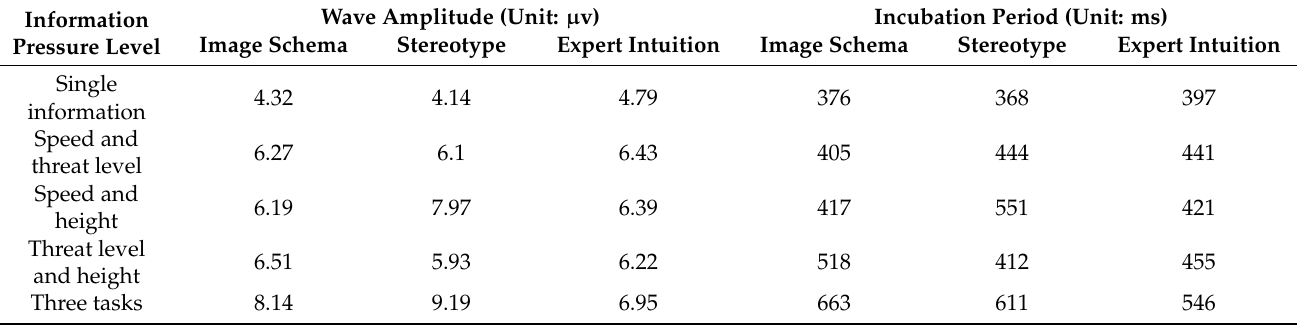
Table 8. Average P300 amplitude and latency under different information pressure